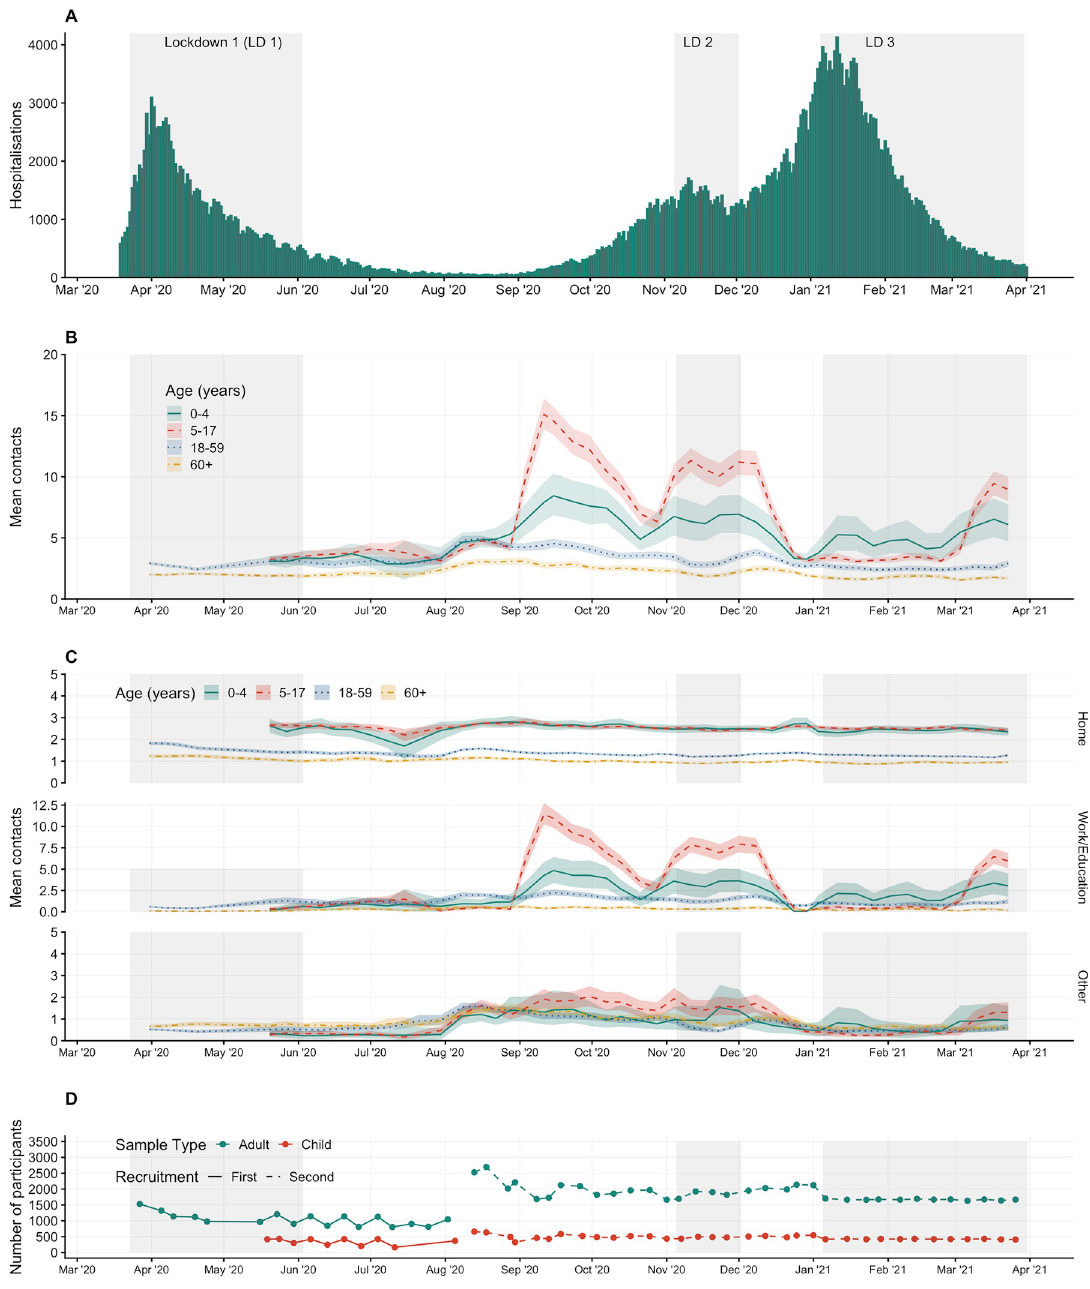
Fig 1. Mean contacts over time by age and by age and setting with timeline of survey participation with 95% CI of bootstrapped mean. (A) Hospitalisations due to COVID-19 in England. (B) Mean contacts and 95% bootstrapped CIs in adults and children in age groups of 0 to 4, 5 to 17, 18 to 59, and 60 or more year. (C) Mean contacts and 95% bootstrapped CIs by age group and setting. (D) The number of participants and when they respond by panel over time. C AU : AbbreviationlistshavebeencompiledforthoseusedthroughoutFigs 1 (cid:0) 6 andTables 2 (cid:0) 4 : Pleaseverifythatallentriesarecorrect : I, confidence interval; COVID-19, Coronavirus Disease 2019; LD,